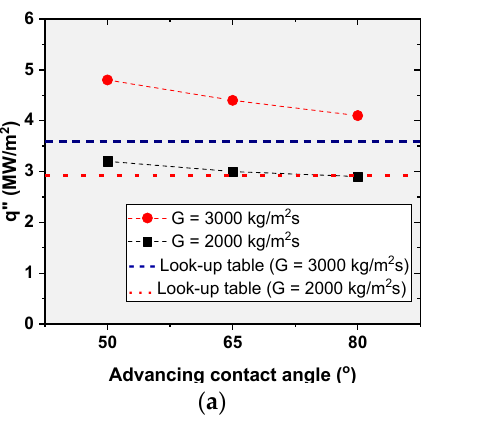
Figure 2. ( a , b ) represent variation in predicted DNB value with different advancing contact angles and contact diameter ratios, respectively. The values predicted by the Look-up table [5] are also plotted for reference. (adapted from Vadlamudi and Nayak [41]).